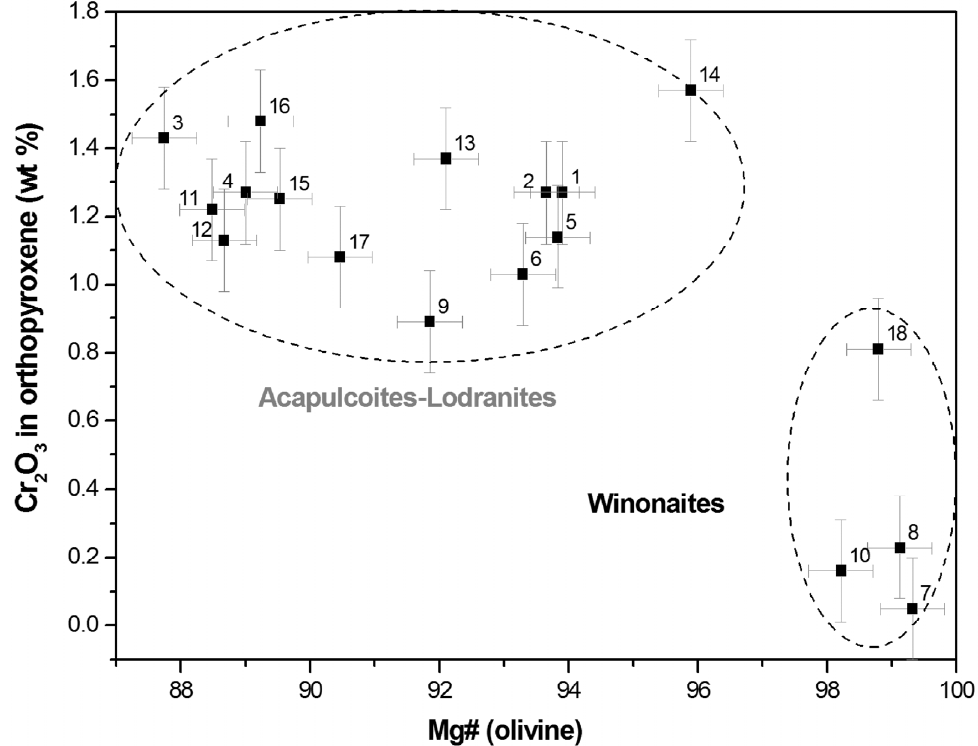
Figure 6. Plot of the Cr 2 O 3 content in orthopyroxene versus the Mg# in olivine. Numbers refer to samples as indicated: 1 = NWA 1052; 2 = NWA 1054; 3 = NWA 3008; 4 = Dho 290; 5 = NWA 1463; 6 = NWA 1058; 7 = Pontlyfni; 8 = QUE 94535; 9 = GRA 98028; 10 = Y-74025; 11 = Y-791491; 12 = Y-74063; 13 = Y-74357; 14 = ALH 81187; 15 = ALH 81261; 16 = ALHA77081; 17 = Y-8005; 18 = A-881902; see Table 2 for sample